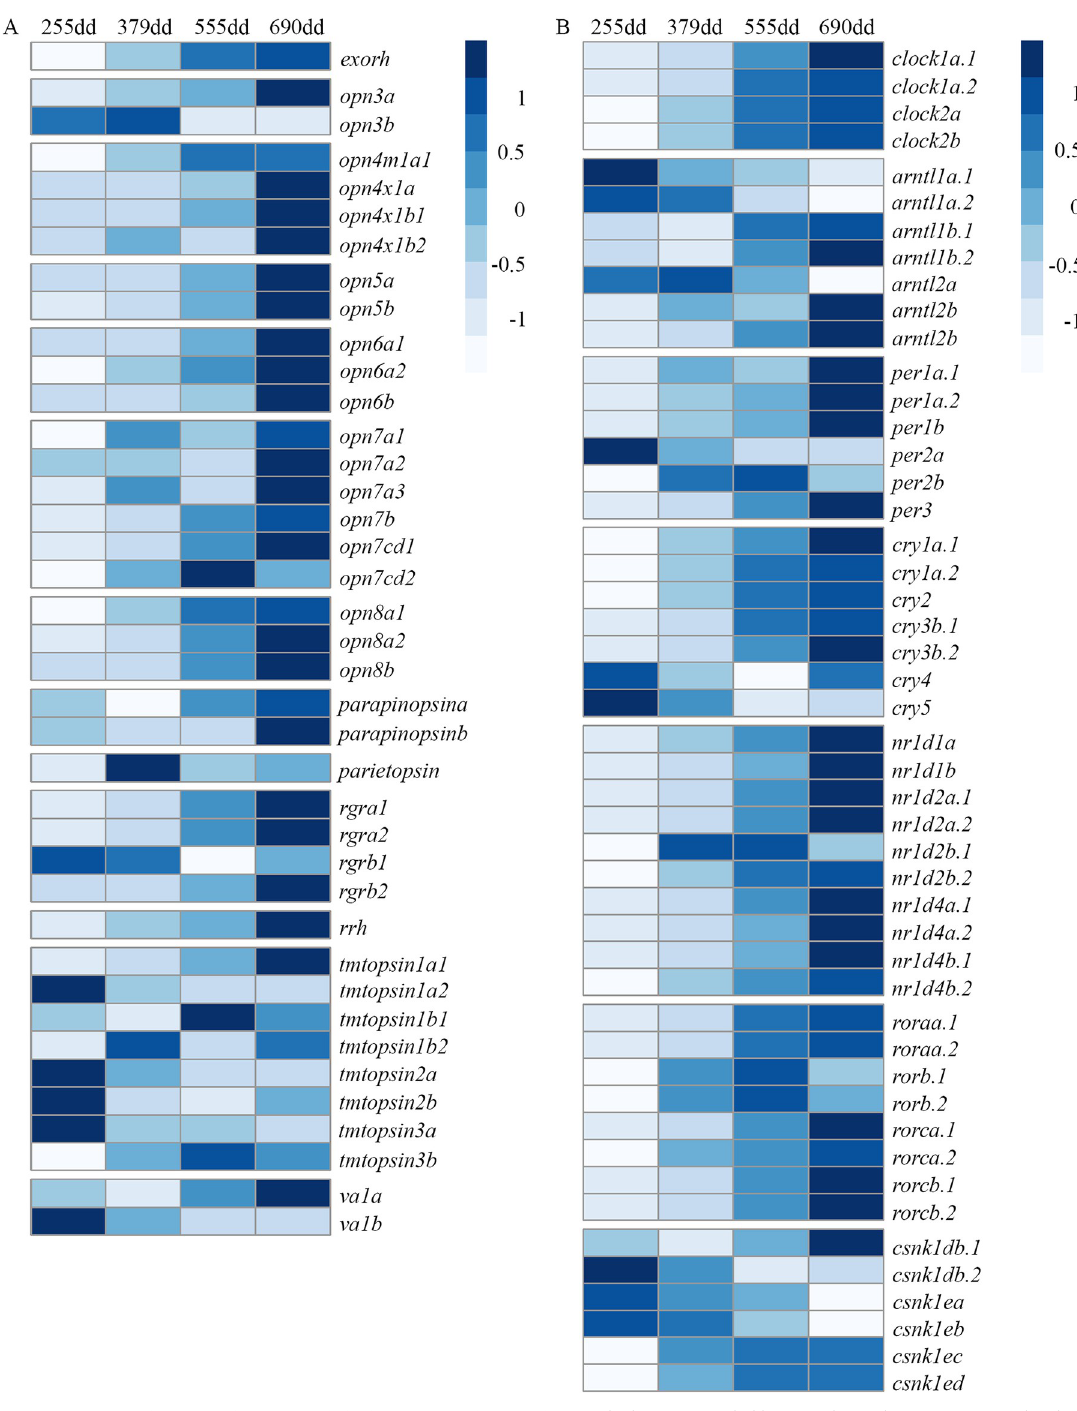
PLOS Genetics | https://doi.org/10.1371/journal.pgen.1010529 December 12,